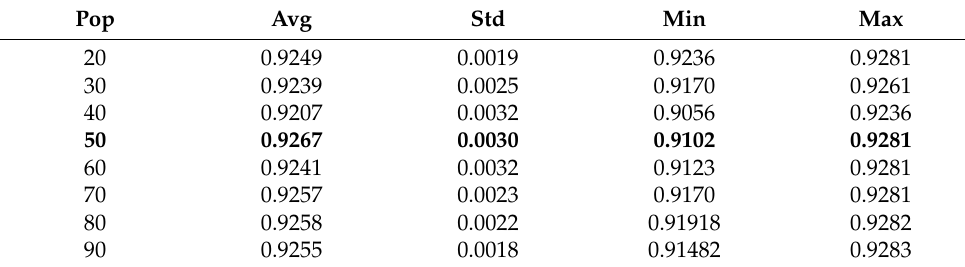
Table 2. Results after varying the number of population (Pop).